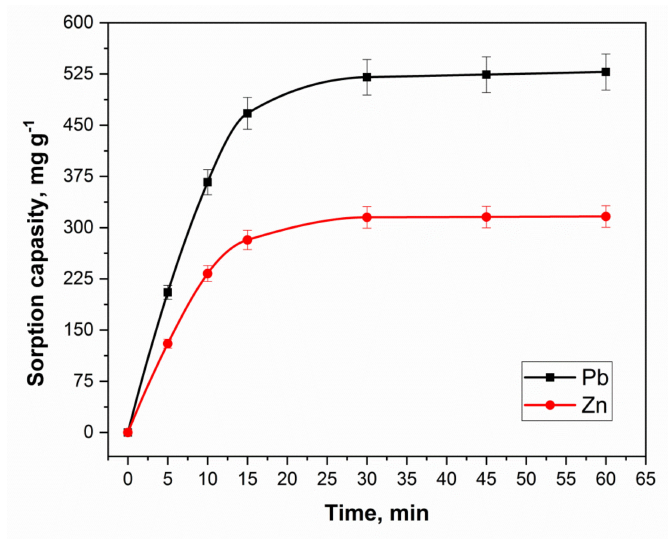
Figure 9. Kinetics of the Pb 2+ and Zn 2+ sorption onto